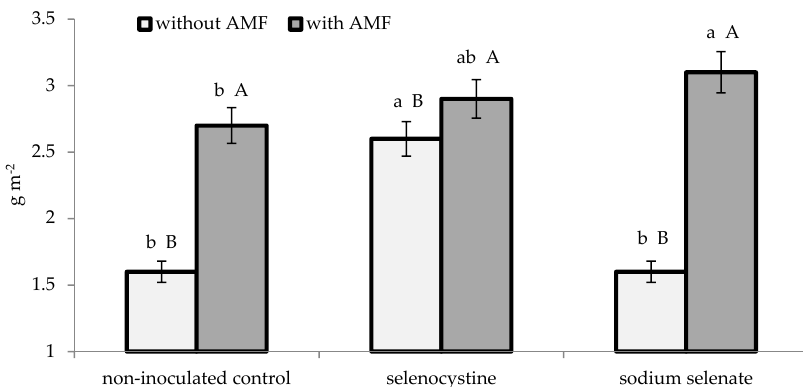
Figure 1. Interaction between microorganism inoculation and selenium treatmenton shallot dry matter. The lowercase letters refer to comparison between the selenium treatments within the AMF formulate and control, while capital letters refer to comparison between the AMF formulate and control within each selenium treatment; this is according to Duncan’s test at p ≤ 0.05 with three replicates per treatment.